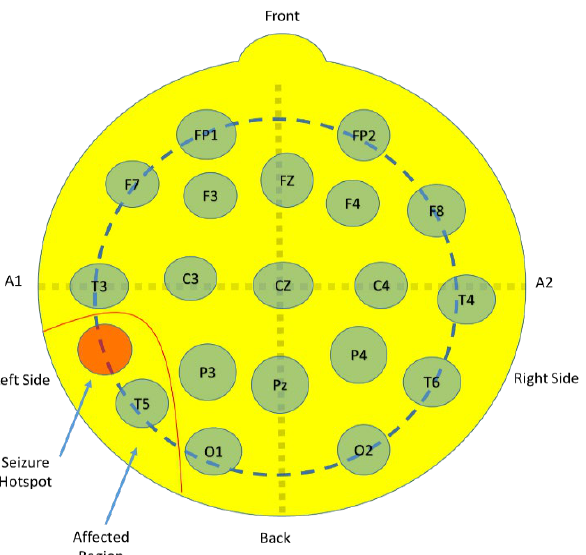
Figure 6. EEG signal acquisition set up using 10–20 international system with seizure hotspot shown in red colour [50].